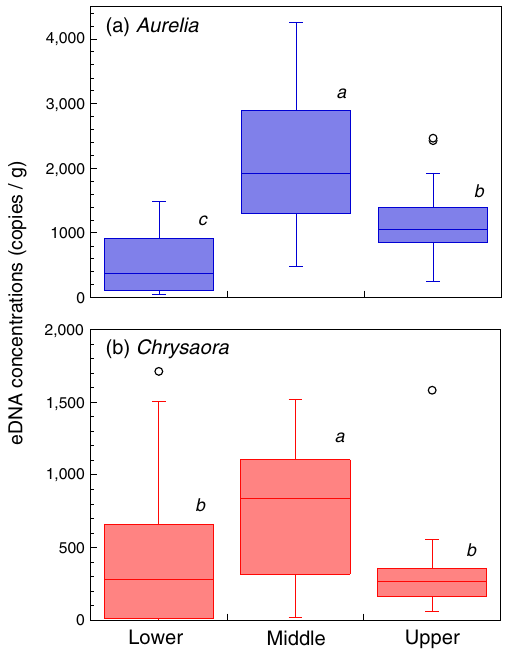
Figure 8. Concentrations of eDNA were compared among the lower (the peak of the polycyclic aromatic hydrocarbons (PAHs) and below), middle (lower half of the layers above the peak of the PAHs), and upper